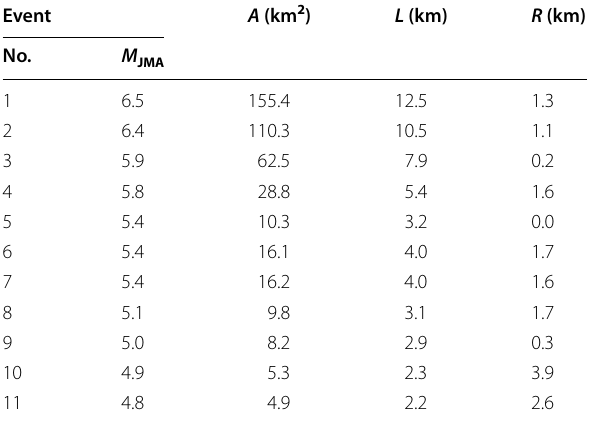
Table 3 Rupture area of the analyzed Kumamoto earth‑ quakes estimated from empirical relation by Somerville et al. (1999) in Eq. (17)